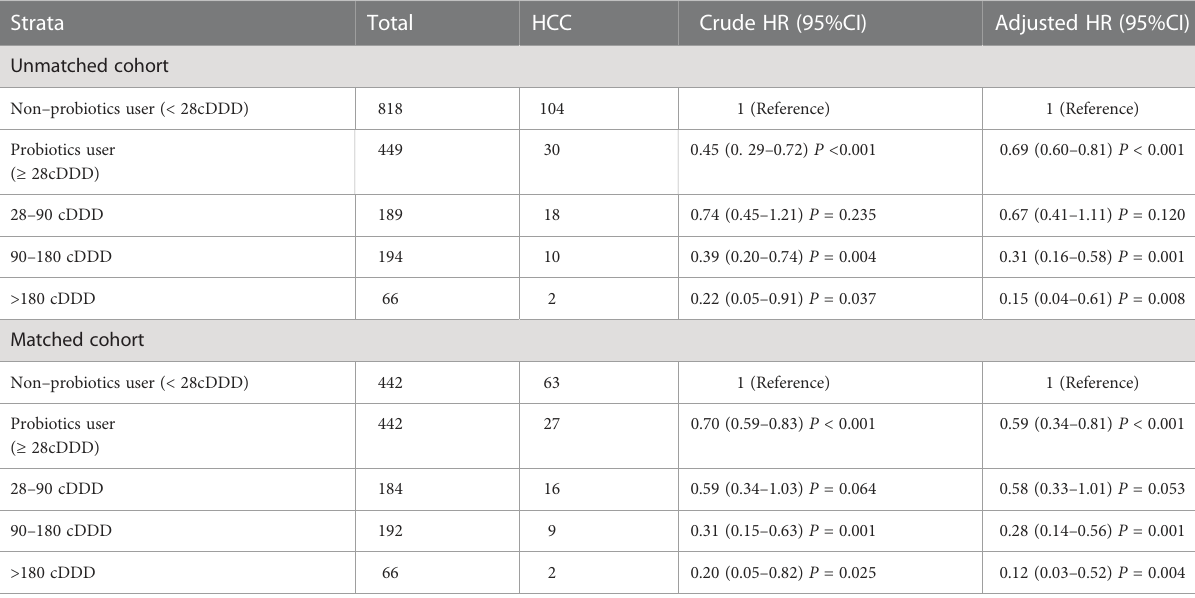
Adjusted HR represents multivariate-adjusted hazard ratio: age, sex, Family history of HCC, ascites, hepatic encephalopathy, alanine aminotransferase, platelet count, NA(s) treatment before ETV/TDF. HR, hazard ratio; cDDD, cumulative de fi ned daily doses; CI, con fi dence interval; HCC, hepatocellular carcinoma; NA(s), nucleos(t)ide analogue(s); ETV, entecavir; TDF,